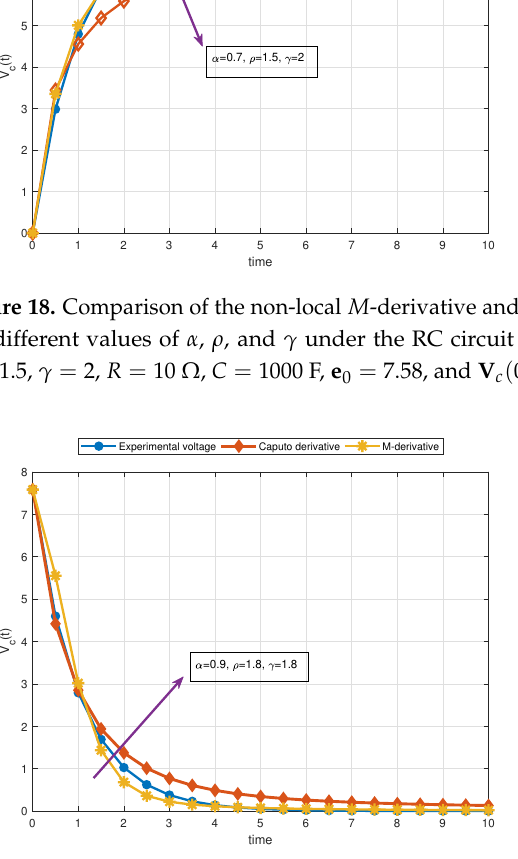
Figure 19. Comparison of the non-local M -derivative and Caputo derivative with experimental data for different values of α , ρ , and γ under the RC circuit including constant source when α = 0.9, ρ = 1.8, γ = 1.8, R = 10 Ω , C = 1000 F, e 0 = 0, and V c ( 0 ) = 7.58.